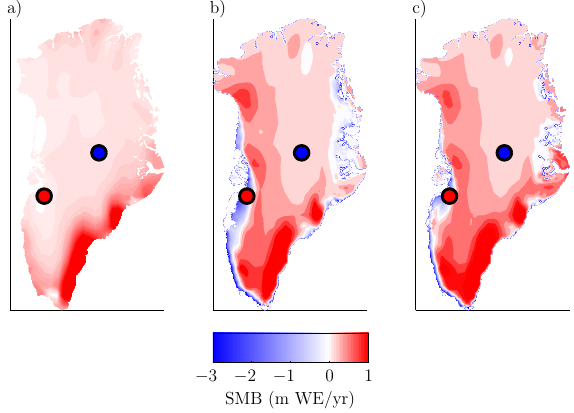
Figure 3. 30-year climatological SMB fields for the LGM (a) , MHO (b) and preindustrial (c) end-member climate states. Blue/red circles: location of the summit/margin SMB time series presented in Fig.